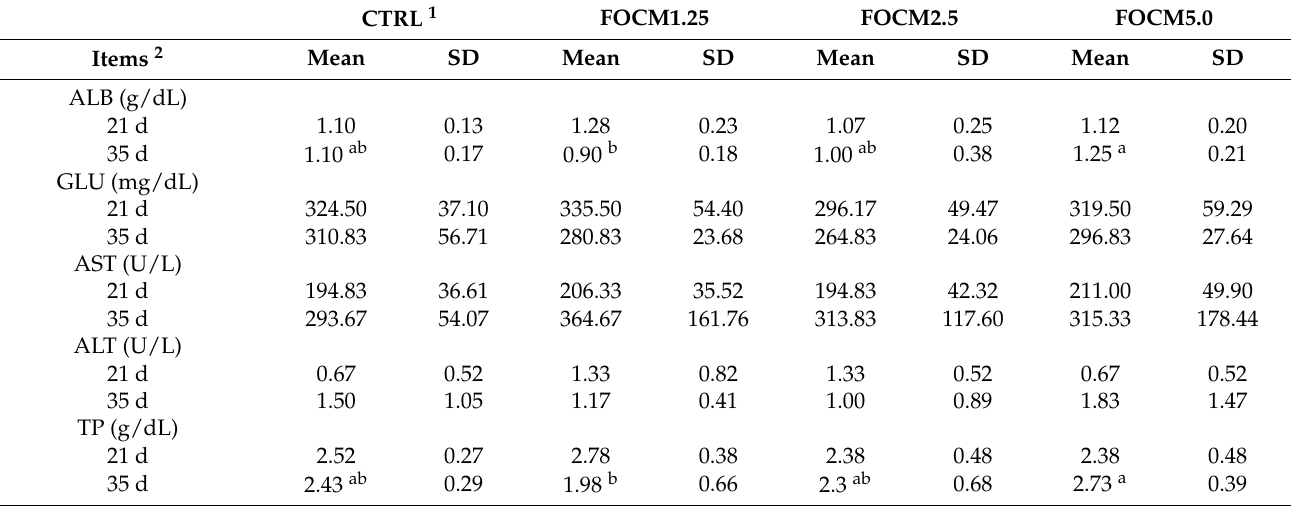
Table 4. Effect of FOCM supplemented in diet on blood biochemistry determined in